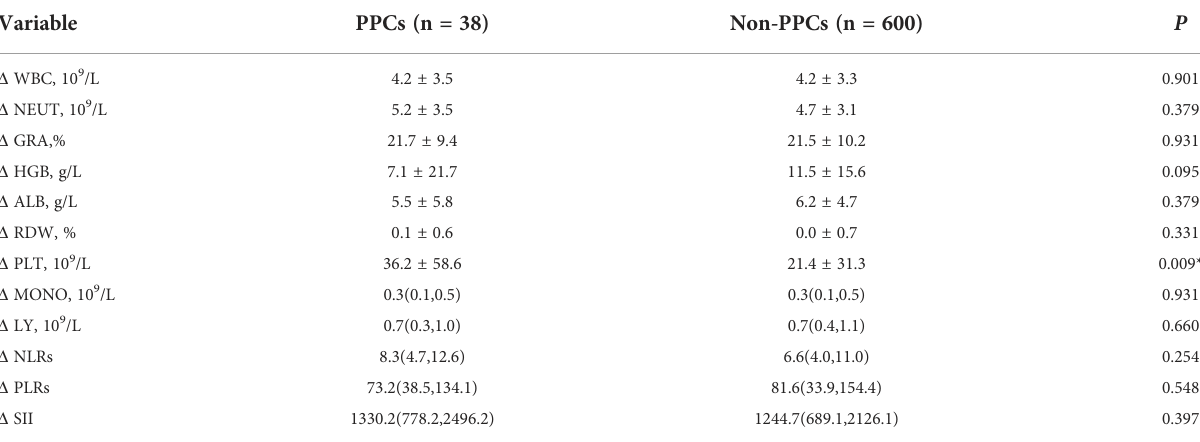
TABLE 5 Value changes in blood test results preoperatively and postoperatively.